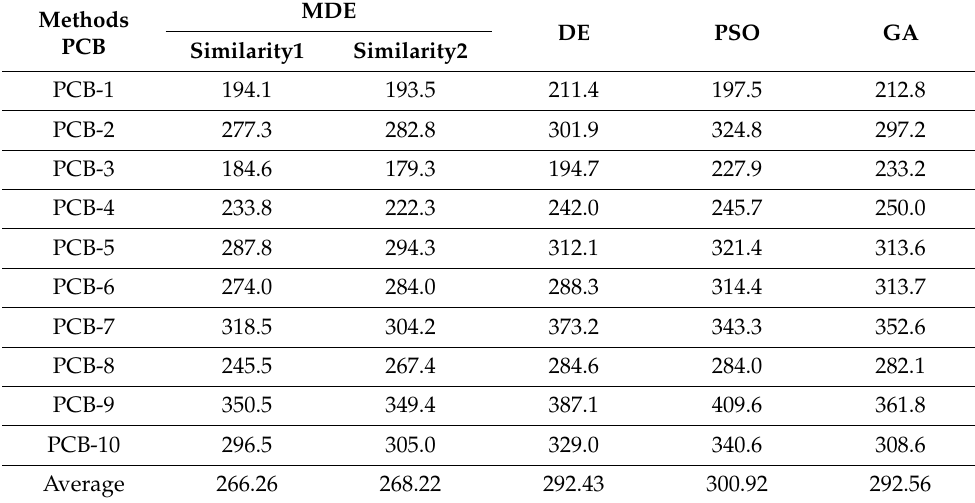
Table 7. Assembly time for each PCB.